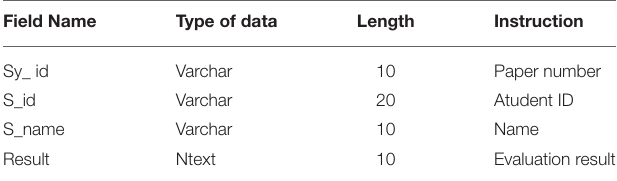
TABLE 1 | Design of evaluation result